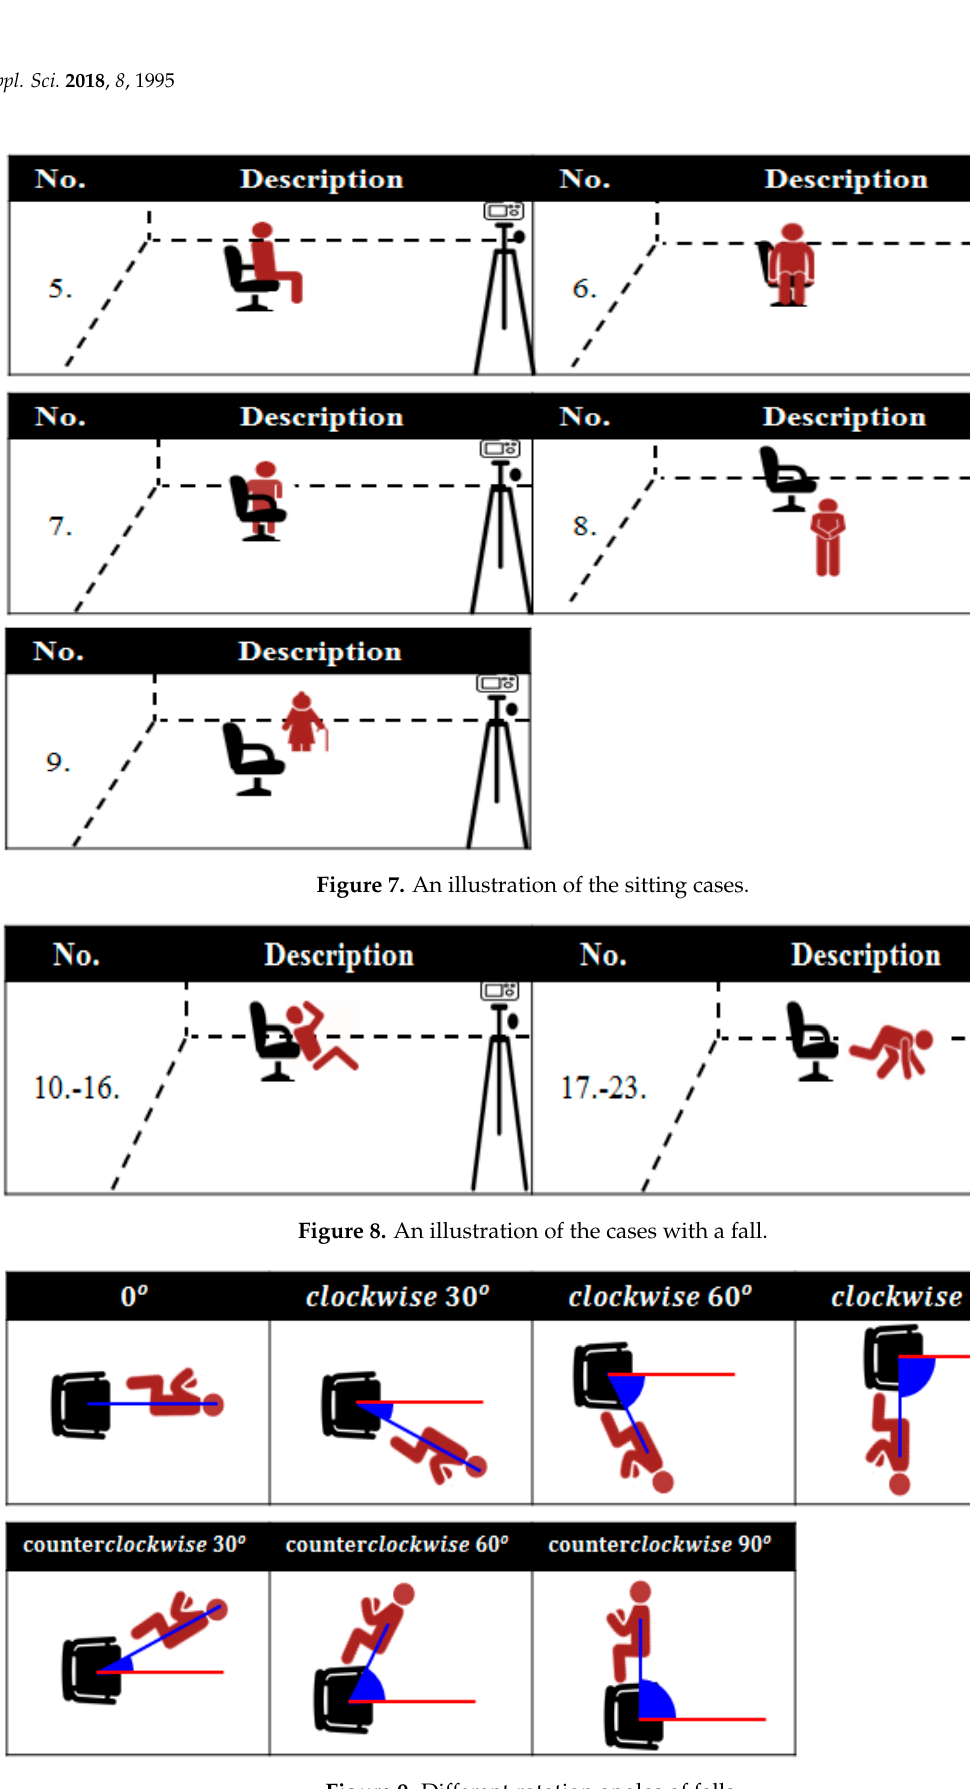
Figure 9. Different rotation angles of falls.